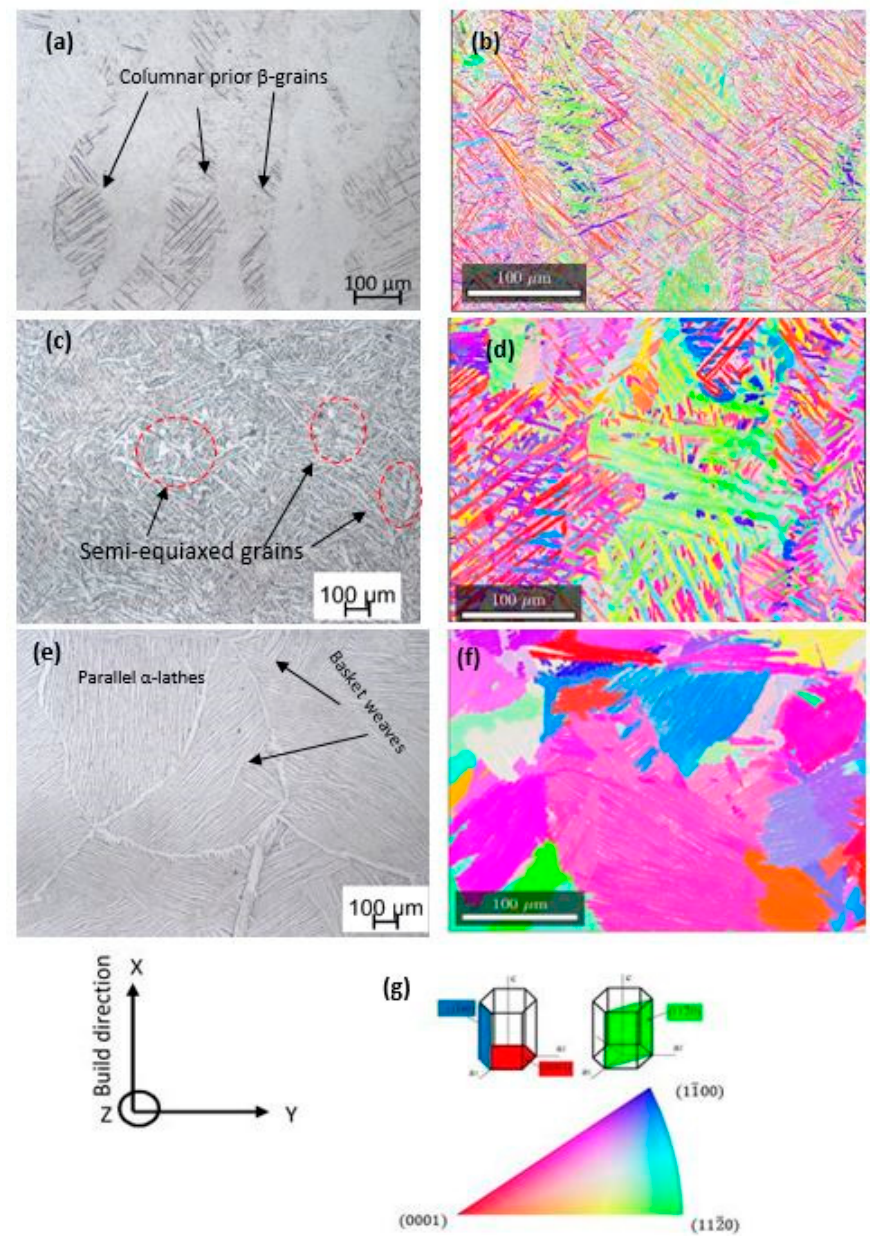
Figure 6. The ( a , c , e ) optical image and ( b , d , f ) Euler orientation maps of ( a,b ) samples A, ( c , d ) samples B, and ( e , f ) samples C, respectively, while ( g ) is the α - hcp principle planes and their depiction in IPF key.